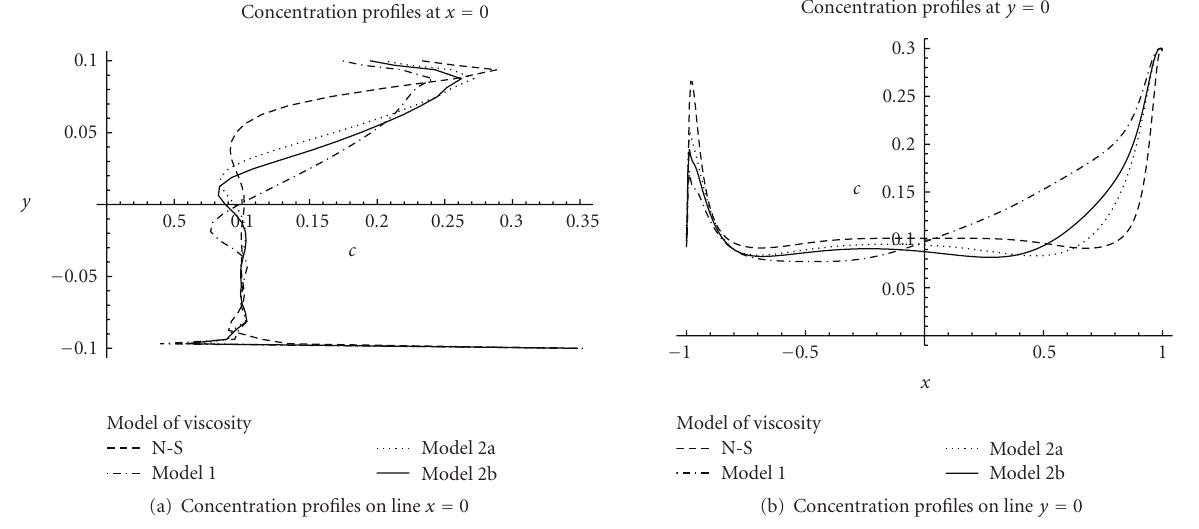
Figure 8: Comparison of concentration profiles on y - and x -cuts.